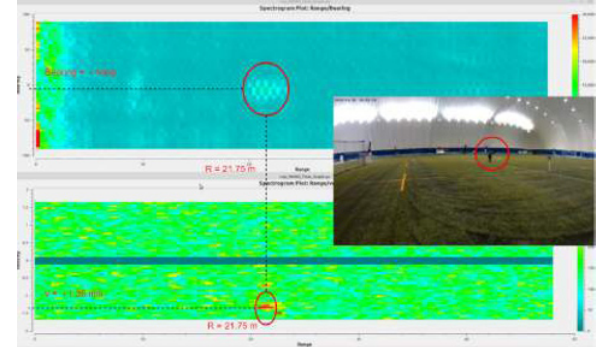
Figure 11. TDM MIMO radar real-time display showing the estimated maximum range of 21.75 m at a velocity of v = − 1 . 35 m / s (opening)